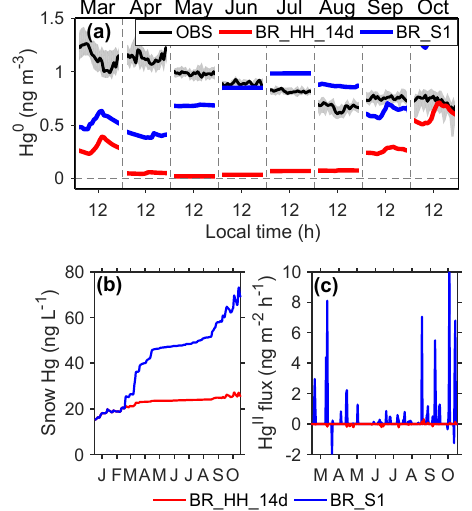
Figure 7. Possible impacts of warming events on mercury concen- trations in the non-summer period. Panel (a) shows Hg 0 observa- tions at 25cm above the snow at Dome C, and the shaded regions in- dicate 25% and 75% percentiles. The modeled Hg 0 concentrations from BR_ HH_14d and BR_S1 are also shown. Panel (b) shows sur- face snow mercury concentrations from BR_HH_ 14d and BR_S1. Panel (c) shows the exchange fluxes of Hg II from the free tropo- sphere modeled by BR_HH_14d and